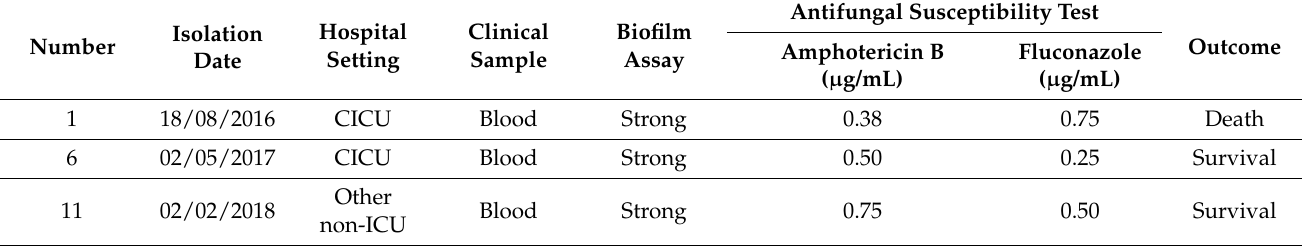
Figure 4. Allelic profile of 40 C. parapsilosis sensu stricto isolates and ATCC 22,019, with a dendrogram showing their clustering. Each line indicates the (id) number of isolates. The black square indicates the presence of an amplification product. Each column corresponds to an allele of the respective polymorphic microsatellite marker (A, B, C, D, G, CP1, CP4, and CP6). Isolates 1, 6 and 11 showed the same allelic profile (clones). Table 1. General data on the origin, year of isolation, and microbiologic characteristics of clonal C. parapsilosis sensu stricto